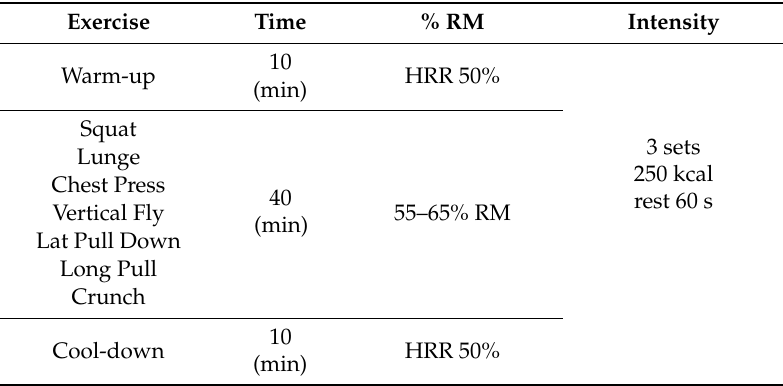
Table 2. Weight-training program.